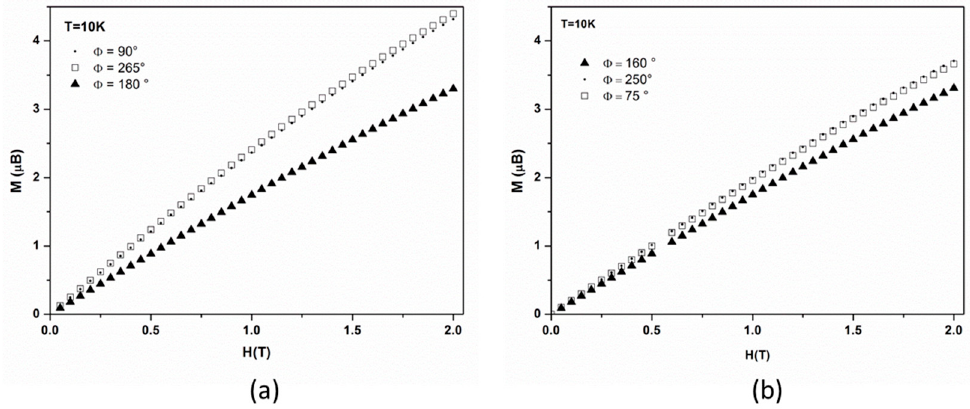
Figure 5. Dependence of the magnetization at 10 K with the magnetic field at the maxima and minima of the χ T ( Φ ) curves: a ) for the rotation around the (cid:1855)(cid:1318) axis and b ) for the rotation around the (cid:1854)(cid:4652)(cid:1318) axis.